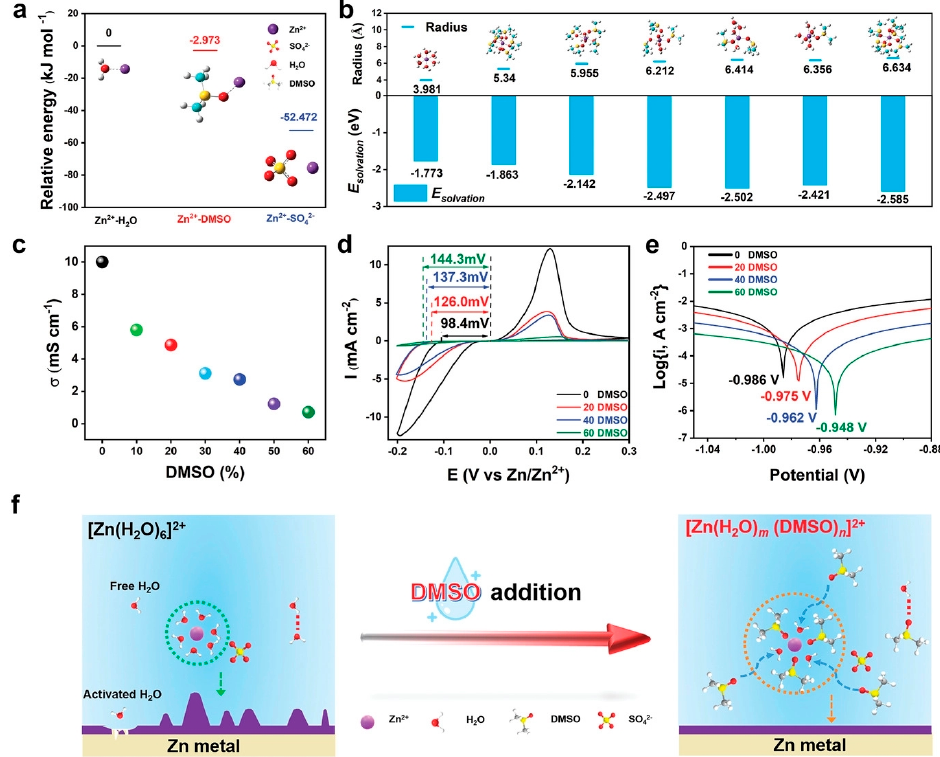
Figure 11. ( a ) DFT calculations for the relative binding energy of Zn 2+ to solvent and SO 42 − . ( b ) The radii and solvation energies of Zn 2+ with different solvation structures. ( c ) Ionic conductivities of aqueous electrolyte and DMSO hybrid electrolytes at 20 °C. ( d ) Cyclic voltammetry curves of the Zn electrode in different electrolytes. ( e ) Tafel curves of the Zn electrode in different electrolytes. ( f ) Conceptual diagrams of the Zn 2+ solvation structure and HBs evolution from aqueous electrolyte to DMSO hybrid electrolytes. Reproduced with permissions from Ref. [96]. Copyright © 2021 WILEY-VCH.